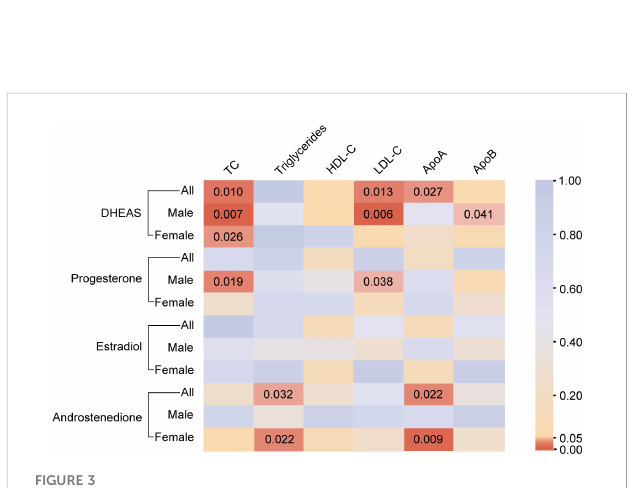
FIGURE 3 The causal association of steroid hormones on lipid metabolism. The color of each block represents the P values of the IVW or Wald ratio method. The brown indicates P < 0.05, and the yellow/blue indicates P > 0.05. P < 0.05 was considered to indicate a signi fi cant correlation. All, total population includes males and females; DHEAS, dehydroepiandrosterone sulfate; HDL-C, high-density lipoprotein cholesterol; LDL-C, low-density lipoprotein cholesterol; IVW, inverse- variance weighted; TC, total cholesterol; ApoA, apolipoprotein A; ApoB, apolipoprotein